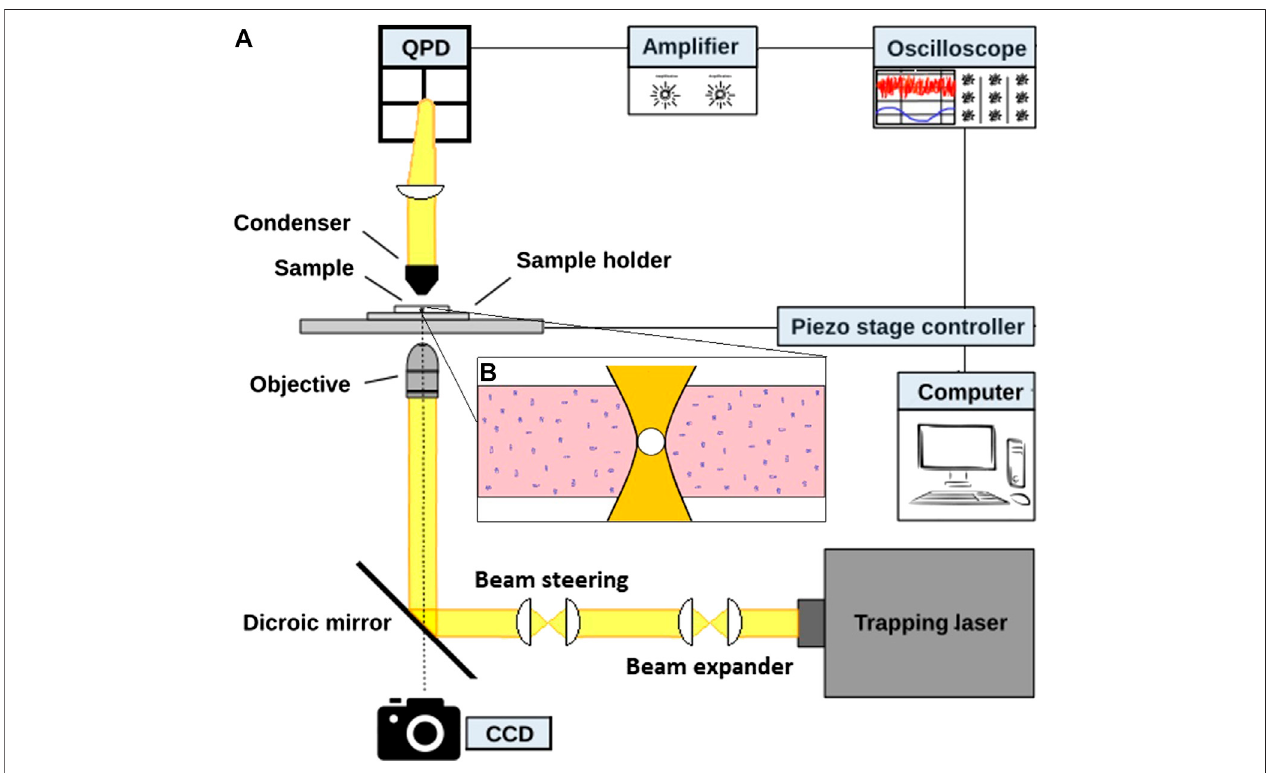
FIGURE 1 | Sketch of the setup. (A) 1,064 nm laser light is directed into an inverted microscope. The microscope objective focuses the laser onto a sample (b) placed on a movable piezo stage. After interacting with the sample, the back-scattered light is collected by a condenser and focused onto a Quadrant Photo Diode (QPD). A CCD camera monitors the sample. (B) Sketch of a sample containing Matrigel solution and an optically trapped tracer